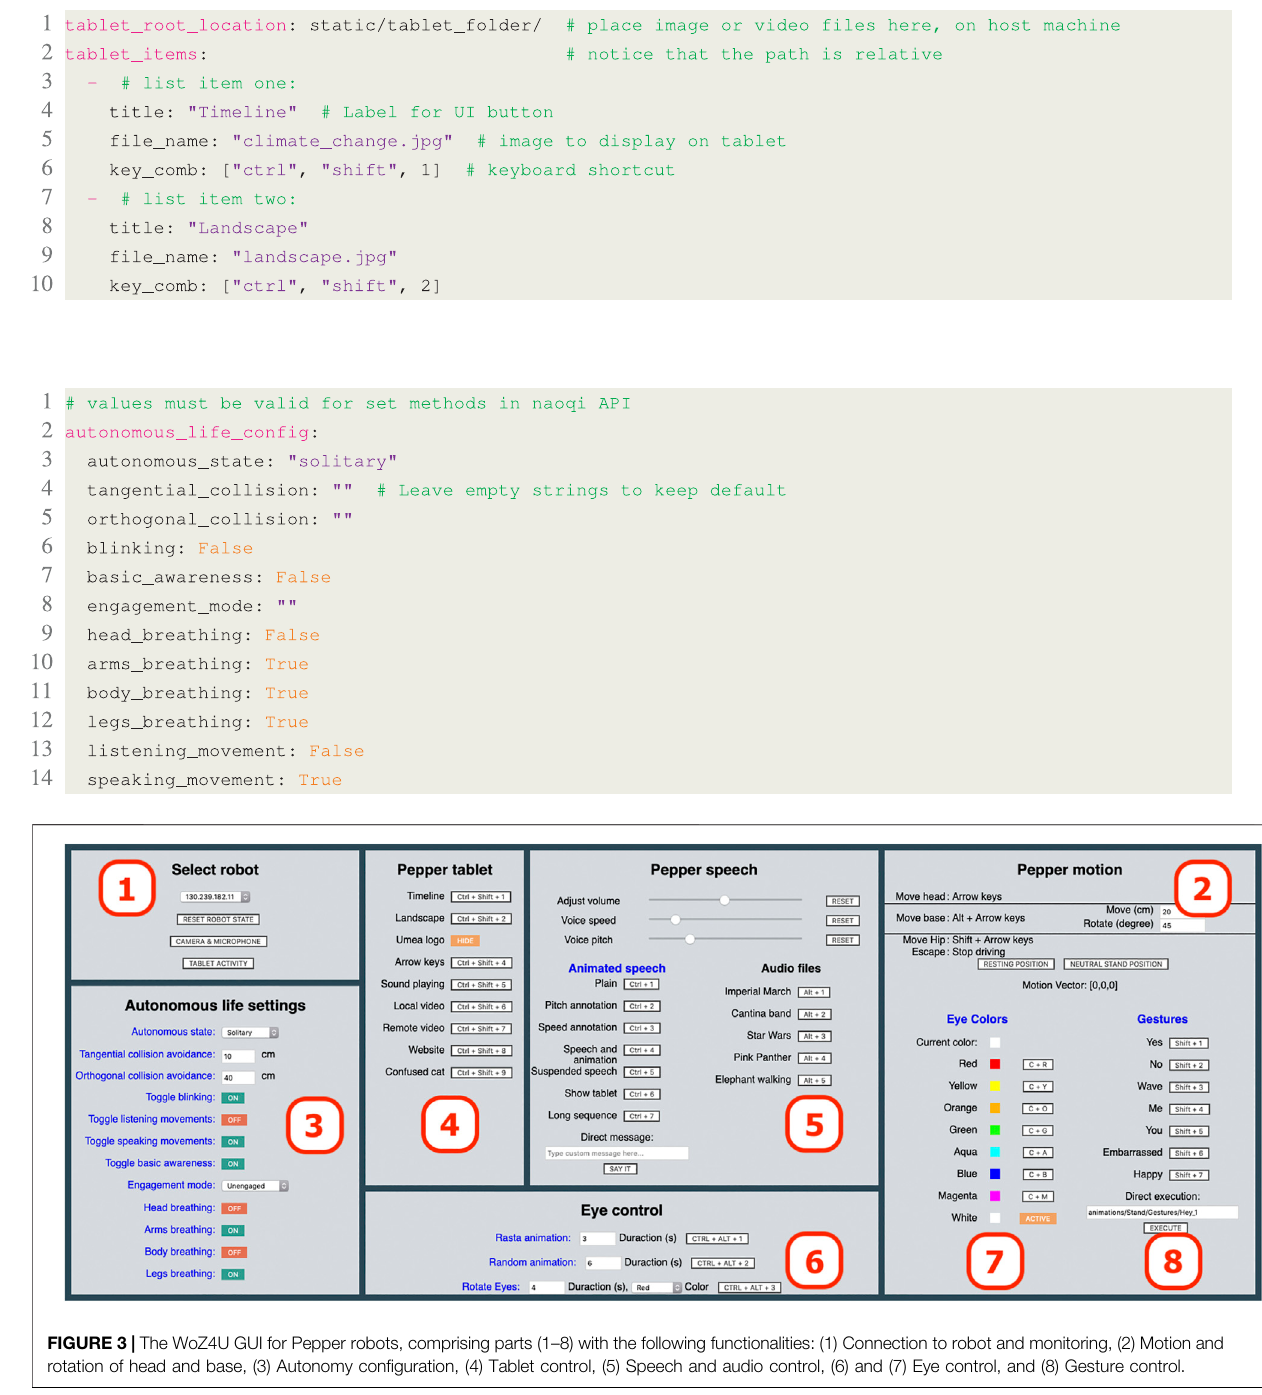
Frontiers in Robotics and AI |